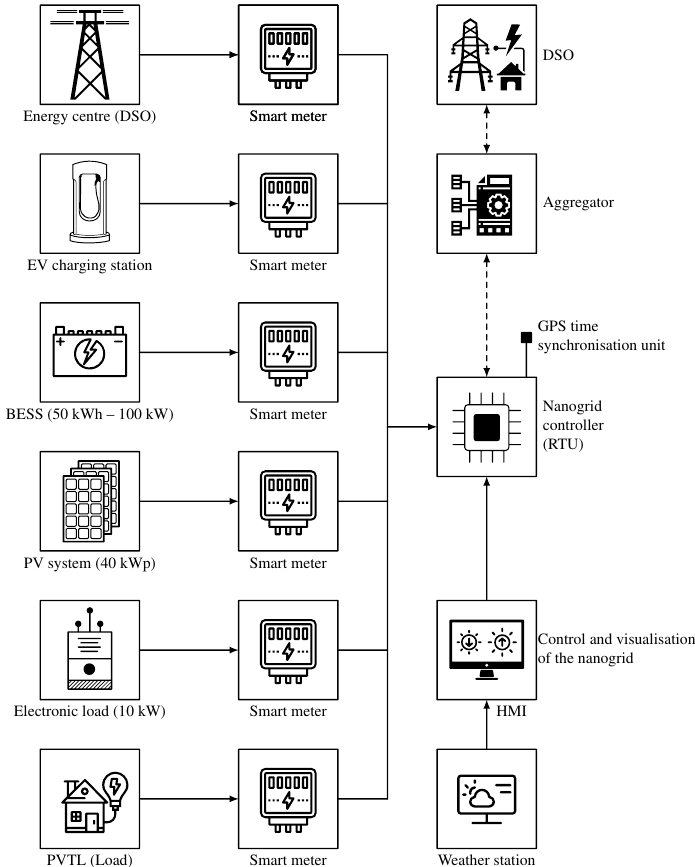
Figure 10. The schematic diagram for the pilot system.